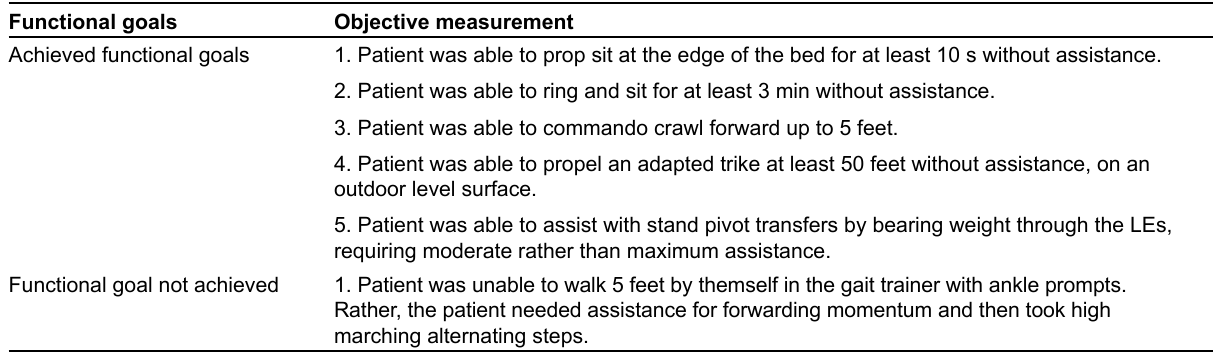
Table 5. Functional